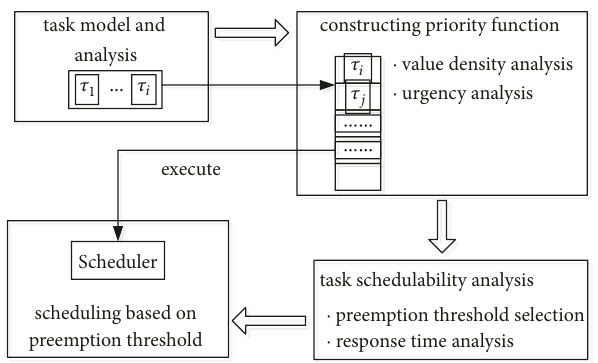
Figure 1: The flow diagram of DSPT